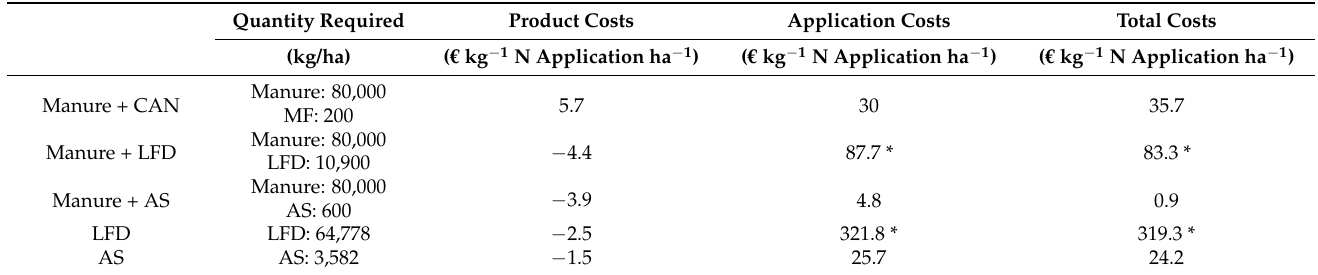
Table 6. The purchase and application costs of the bio-based fertilisers liquid fraction of the digestate (LFD) and Ammonium Sulphate (AS) and the mineral fertiliser